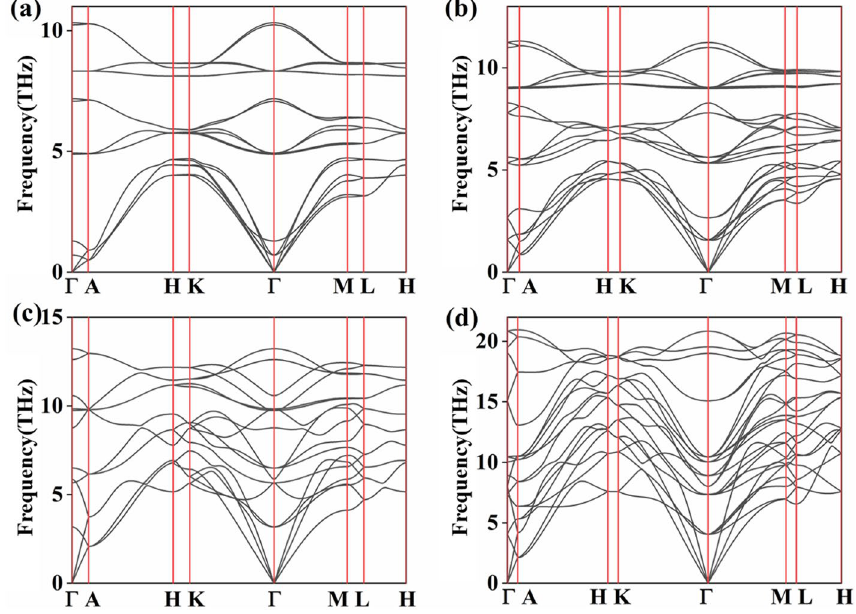
Figure 3. The phonon dispersion curves of MoSe 2 . ( a ) P 6 3 /mmc under 0 GPa, ( b ) R 3 m under 20 GPa, ( c ) P 6 3 / mmc under 80 GPa, and ( d ) R -3 m under 500 GPa, respectively.